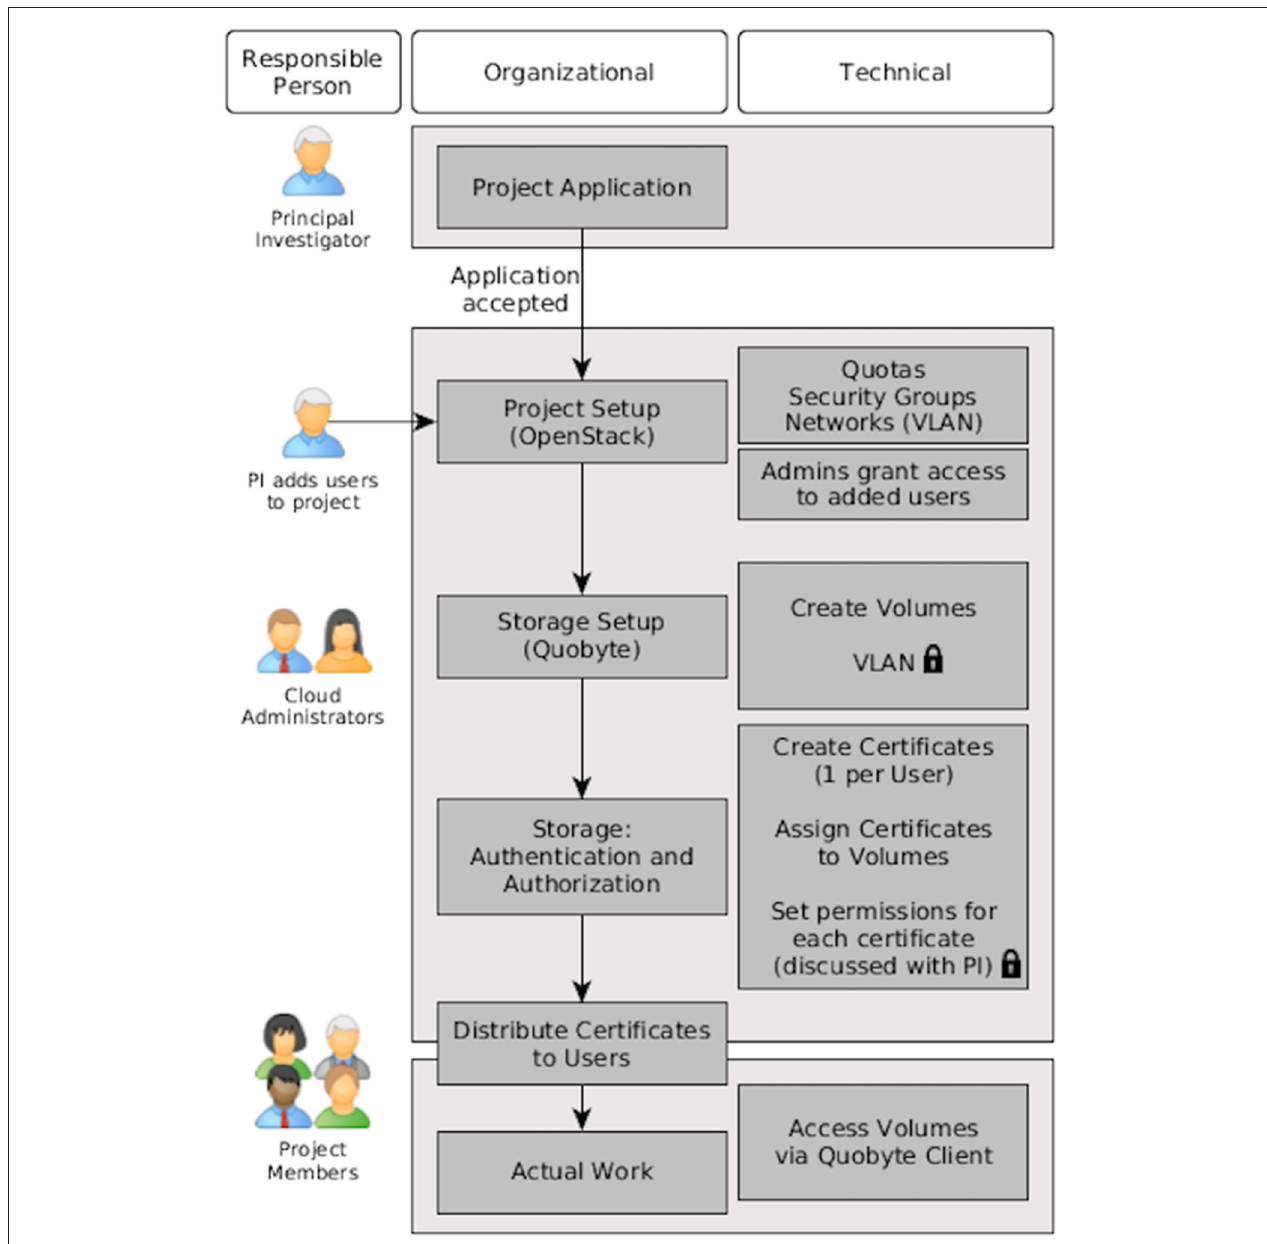
FIGURE 4 | Data management and access workflows in the Lux-GIANT